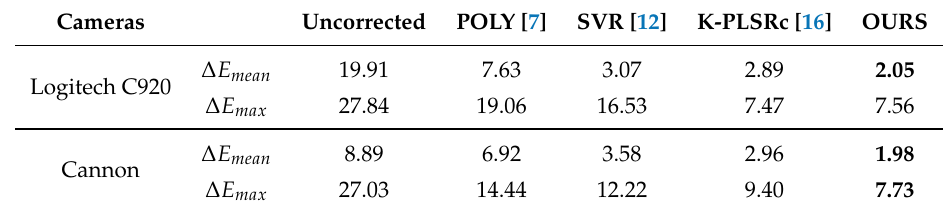
Table 5. Comparison results of the color differences using the four methods with different cameras. Cameras